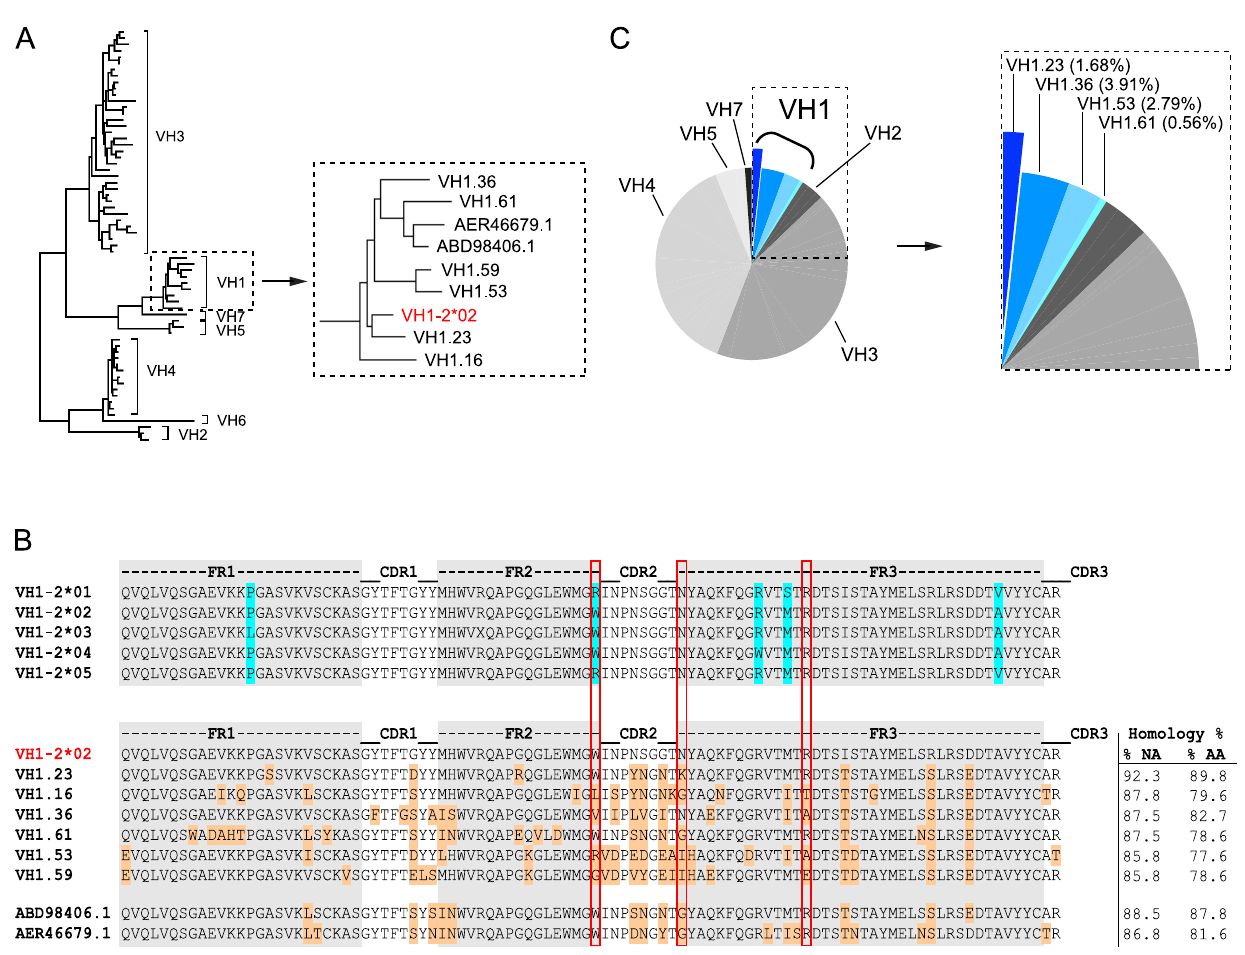
Figure 1. NHP VH1 gene segment usage. (A) Phylogenetic representation of known rhesus macaque VH germline sequences. The VH1 family is boxed and shown in a magnified view to highlight the VH1 rhesus macaque germline sequences in relation to the human VH1-2*02 germline sequence (red). (B) Sequence alignments of all known human VH1-2 alleles are shown in the top panel. Framework (FR) regions are shaded in gray with the amino acid differences between the alleles highlighted in blue. Sequence alignments of the human VH1-2*02 germline sequence with the known rhesus VH1 germline sequences are shown in the lower panel. Differences between human VH1-2*02 and the rhesus germline sequences are highlighted in orange and the percentage nucleic acid (NA) and amino acid (AA) homologies are indicated to the right after each germline sequence. The W50/N58/R71 motif, which is typically present in VH1-2*02-using bNAbs, is highlighted by the vertical red boxes. (C) Pie-chart indicating the family usage of 179 VH sequences isolated from animal F128. Sequence ‘‘slices’’ belonging to the VH1 family are boxed and highlighted in different shades of blue. The percentage of sequences annotated to a given germline gene segment within the VH1 family is indicated in parentheses in the magnified view to the